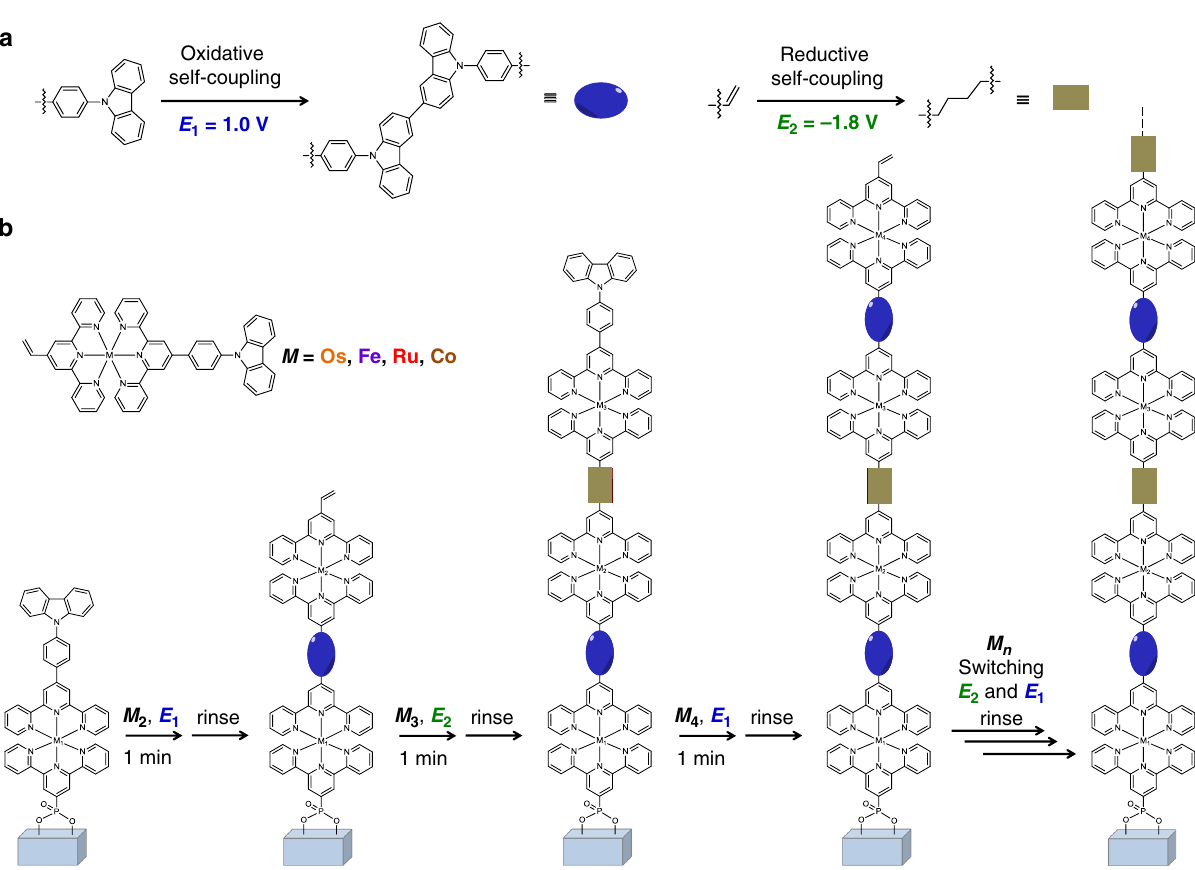
Fig. 1 Rapidly sequence-controlled electrosynthesis of organometallic polymers. a Illustrations of electrochemical oxidative and reductive couplings for iterative synthesis at 1.0 V and − 1.8 V, respectively, on ITO coated glass. b Illustration of iterative synthesis of sequence-controlled organometallic polymers by switching oxidative and reductive reactions of distinct